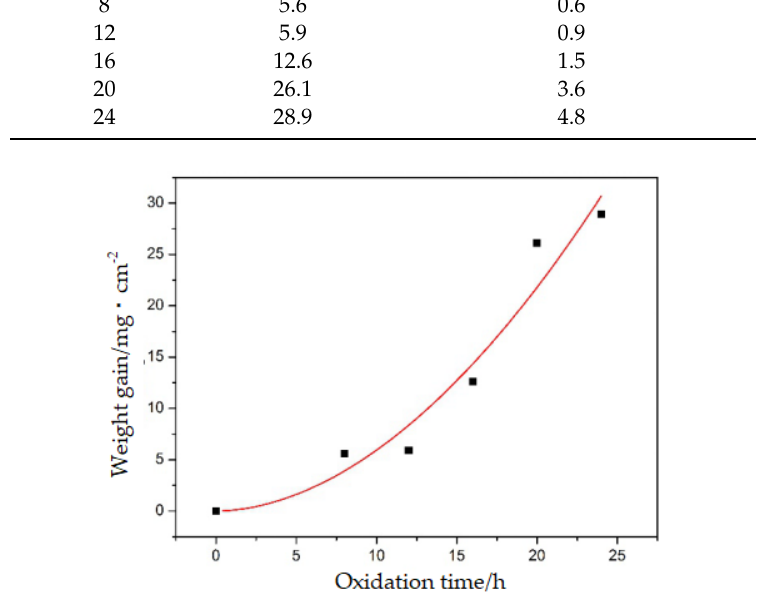
Figure 11. Weight gain curves of Ni coating.